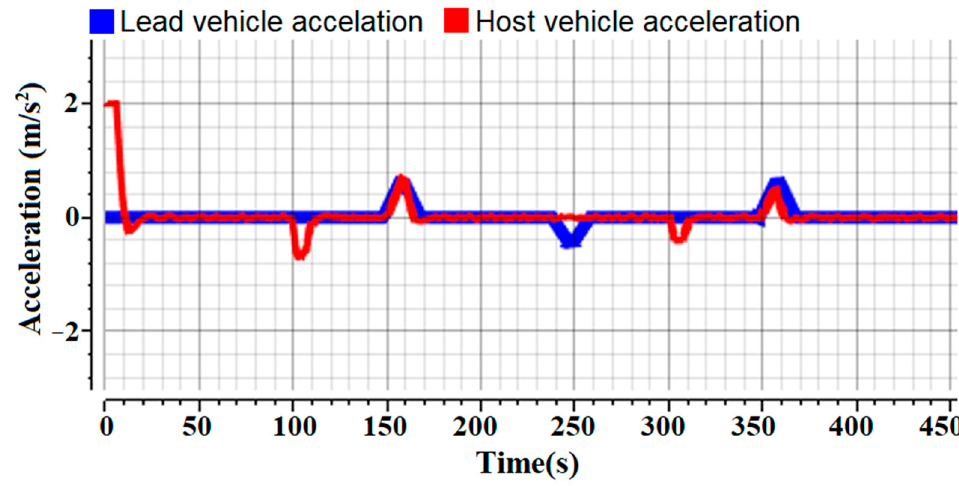
Figure 22. Acceleration of the leading vehicle and host vehicle (experimental results).